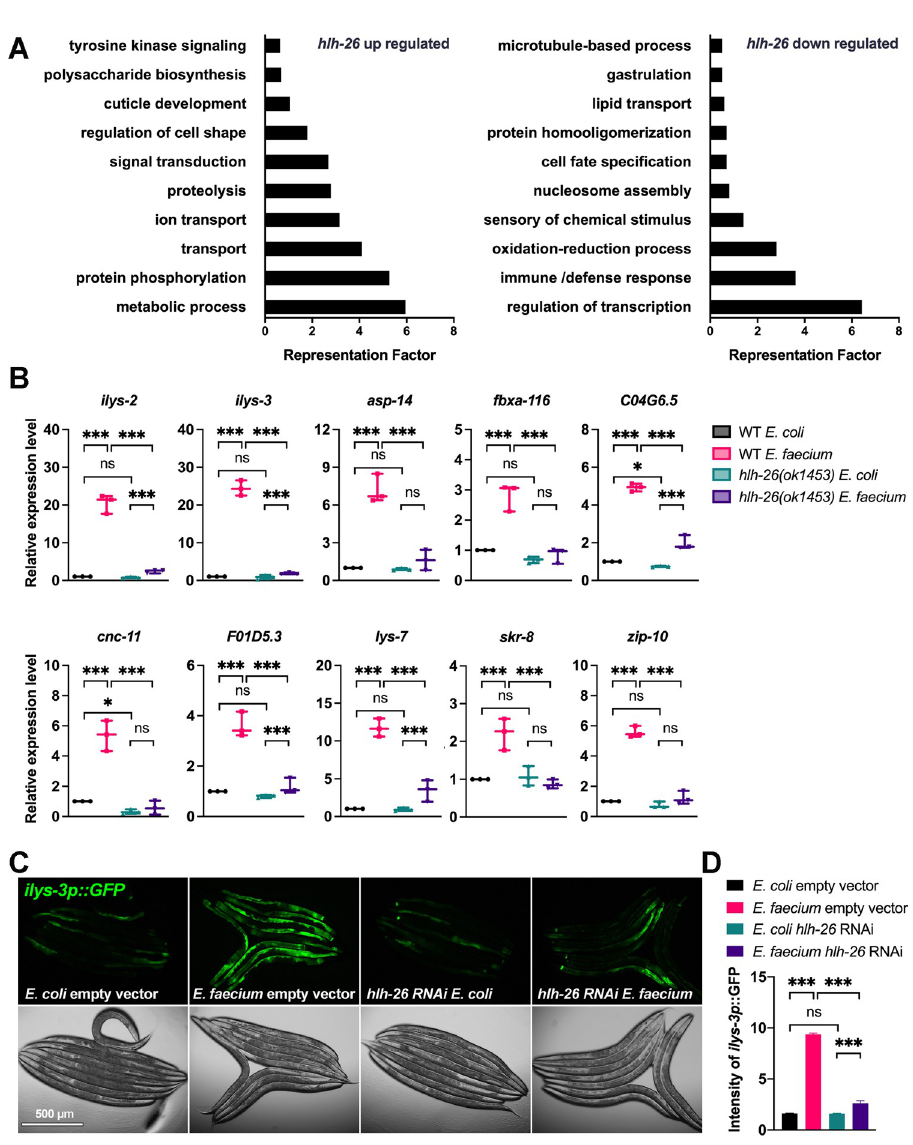
Fig 4. HLH-26 regulates an innate immune transcriptional program. (A) GO analysis of up-regulated and down- regulated genes in hlh-26(ok1453) animals grown on E . faecium . (B) qRT-PCR validation of selected innate immune genes that were down-regulated in hlh-26(ok1453) mutants ( N = 3 biological replicates). Values are expressed as the fold difference compared with wild-type worms fed on E . coli ± SD by one-way ANOVA with Tukey’s multiple comparisons test, � P < 0.05, �� P < 0.01, ��� P < 0.001. (C) Fluorescence micrographs of control or hlh-26 RNAi animals expressing GFP under the ilys-3 promoter ( ilys-3p :: gfp ) after an 8-h exposure to E . faecium or E . coli . (D) Quantification of the animals shown in (C), n = 8. The “n” represents the number of animals in each experiment. N = 3 biological replicates. The data underlying all the graphs shown in the figure can be found in S1 Data. GO, gene ontology; ns, nonsignificant; qRT-PCR, quantitative reverse transcription PCR; RNAi, RNAi interference; WT, wild- type. regulated genes with changes in expression upon exposure to E . faecium . Using WormExp (https://wormexp.zoologie.uni-kiel.de/wormexp/), which is a web-based application for gene set enrichment analysis specific for C . elegans , we found that several hlh -26–regulated genes were also controlled by several other pathways (S7 Table). We then studied E . faecium –medi- ated protection against S . enterica infection of C . elegans mutants by examining genes